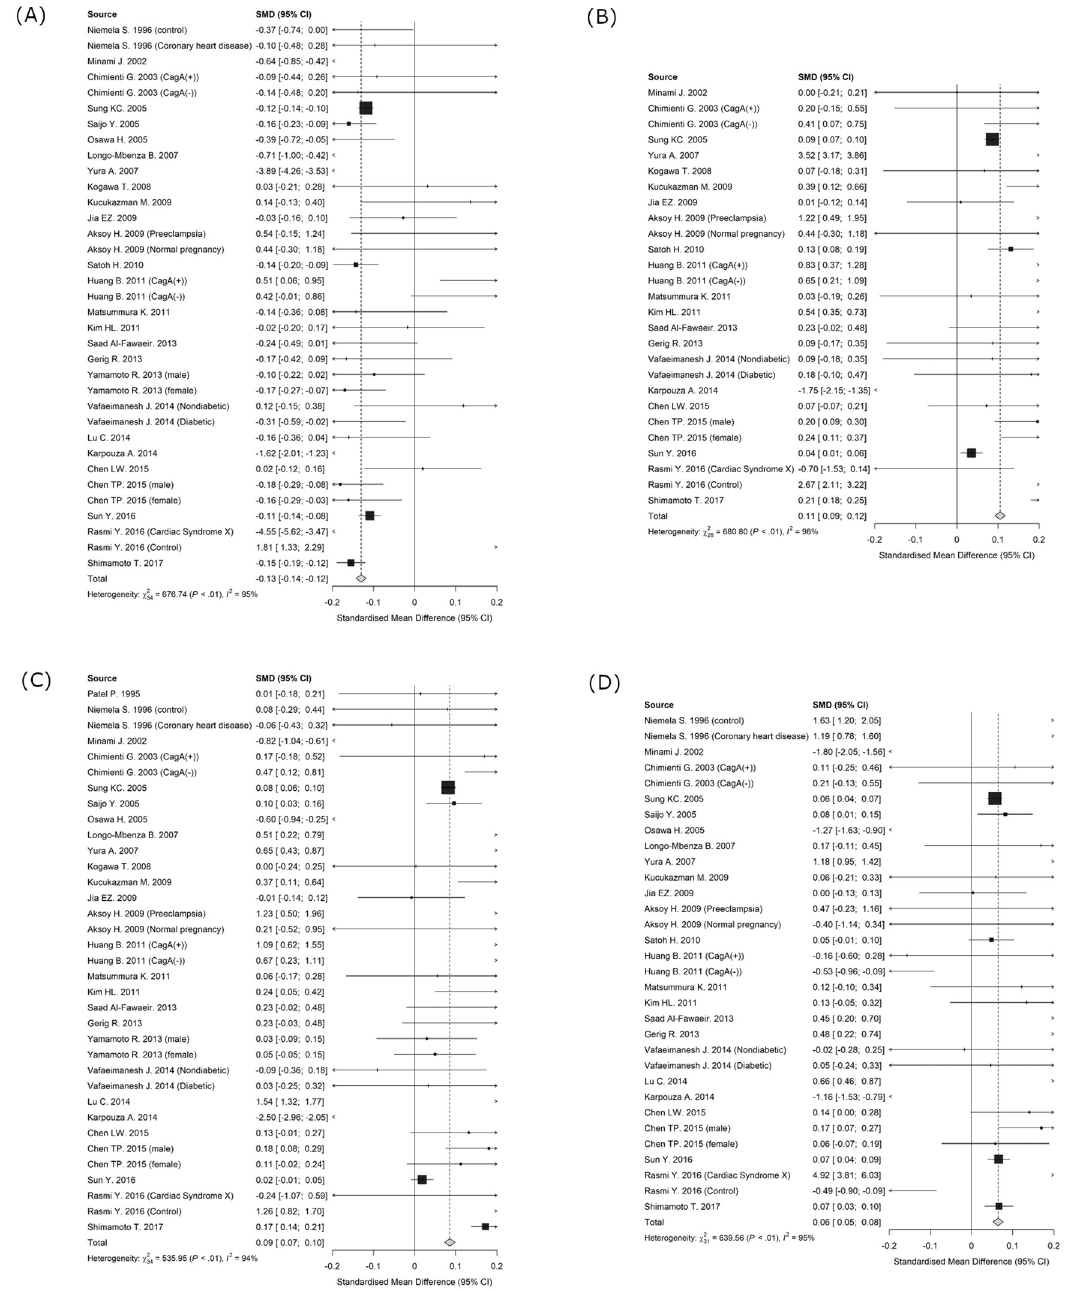
Fig 2. Forest plots of odds ratio (OR) with 95% confidence interval (CI) showing the effect of Helicobacter pylori infection in each lipid profile. The gray box represents an estimate of the OR in the respective studies, and the horizontal line indicates the 95% CI for the respective studies. Diamonds at the bottom represent the pooled estimate of OR. Weights are from fixed-effects meta- analysis. The chi-squared ( x 2 ) test revealed the presence of heterogeneity. The I 2 value shows the extent of heterogeneity. (A) High- density lipoprotein cholesterol (HDL-C), (B) low-density lipoprotein cholesterol (LDL-C), (C) total cholesterol (TC), and (D) triglyceride (TG).